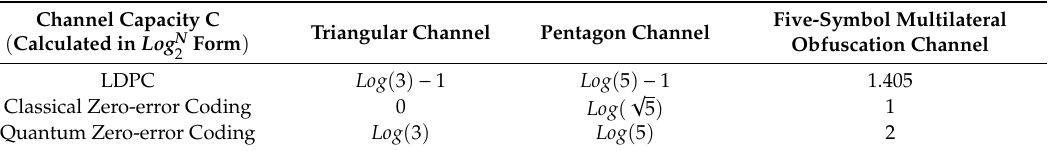
Table 1. The channel capacity of zero-error coding and its low density parity check code (LDPC)